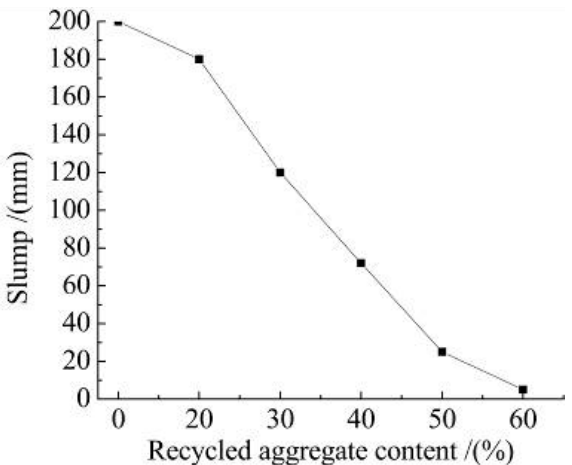
Figure 2. The slump of recycled concrete with different recycled aggregate content.